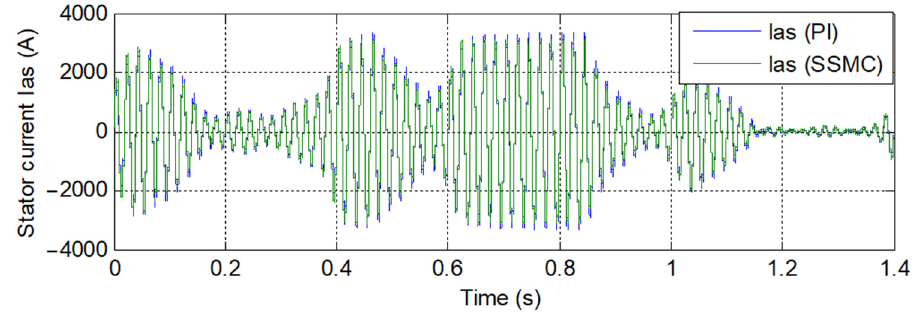
Figure 17. Torque.